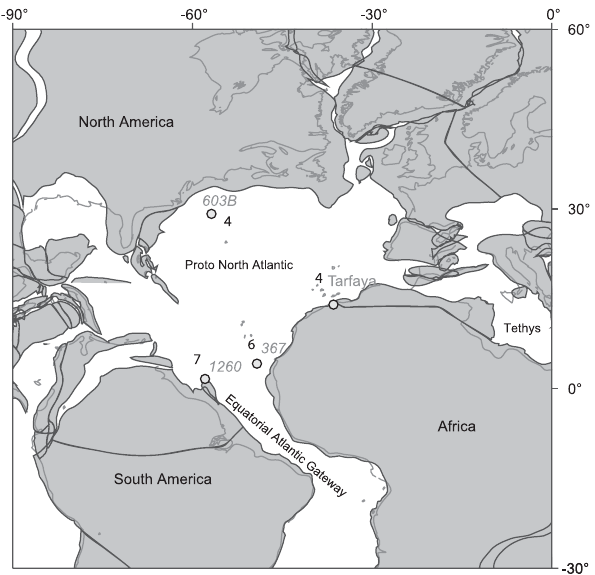
Fig. 1. Reconstruction of the proto-Atlantic Ocean during the Ceno- manian/Turonian created with GEOMAR map generator; www. odsn.de/odsn/services/paleomap/paleomap.html. Circles indicate the paleo-location of the discussed records. For each site the am- plitudes of the OAE-2 δ 13 C phytane excursion (in ‰) is indicated in black numbers (Site 1260, this study; Site 367, Kuypers et al., 2002b; Tarfaya, Tsikos et al., 2004; Site 603B, Sinninghe Damst´e et al.,